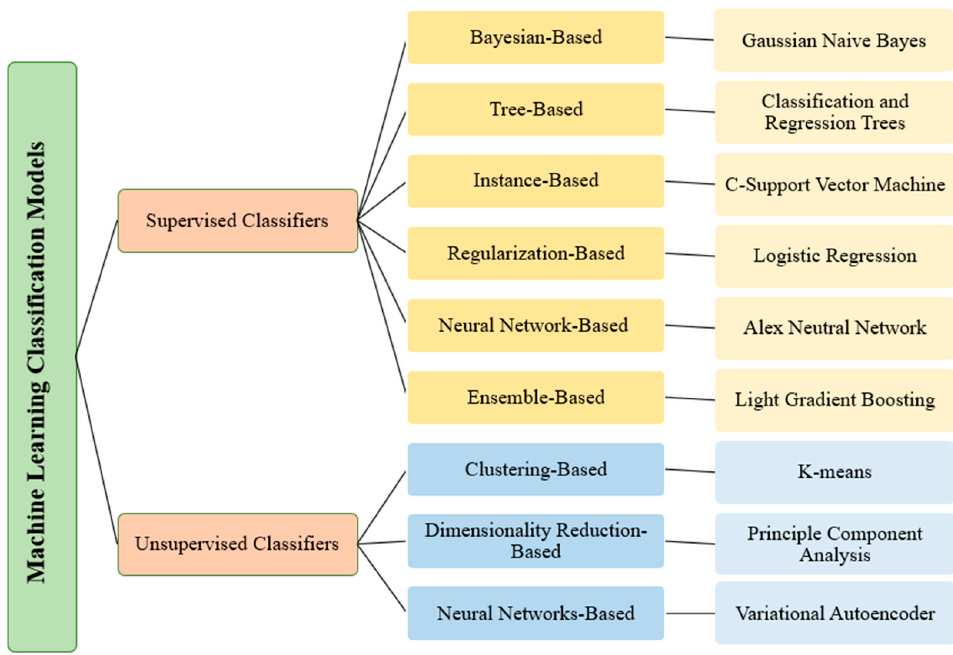
Figure 2. Classification of ML models used in this